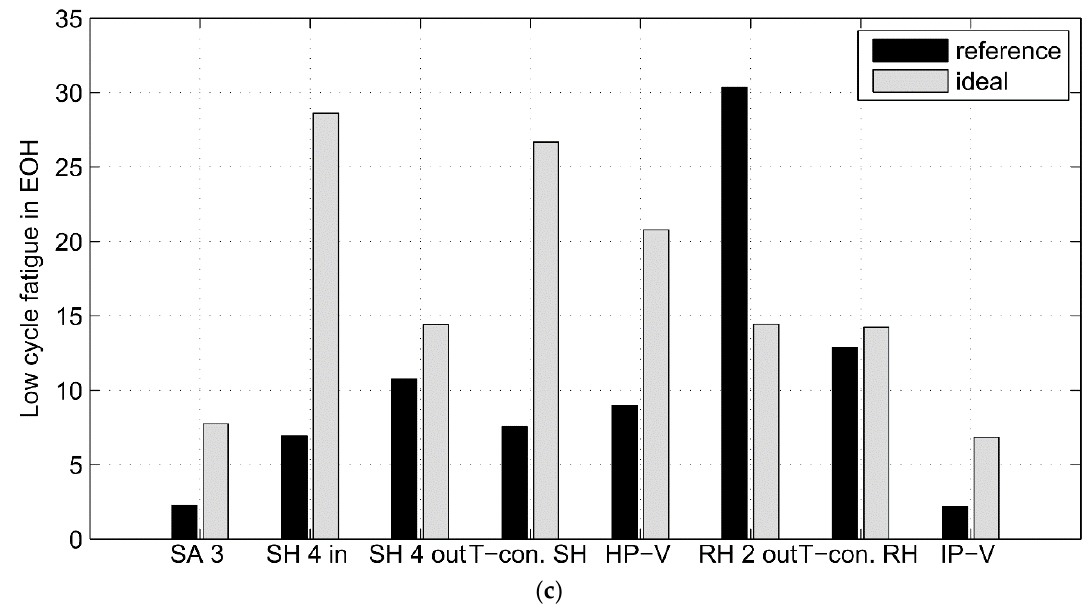
Figure 7. Simulation results during hot start-up for 8 of the most critical thick-walled components (SA3: spray attemperator 3. SH4 in/out: superheater 4 inlet/outlet, T-con. SH/RH: turbine connection to superheater/reheater, HP/IP-V: high/intermediate pressure valve, RH 2 out: reheater 2 outlet): ( a ) Maximum wall-temperature difference; ( b ) Maximum stress amplitude to endurance strength ratio; ( c ) Low cycle fatigue (EOH: equivalent operating hours);Reprint with permission [72]; 2017, Elsevier.